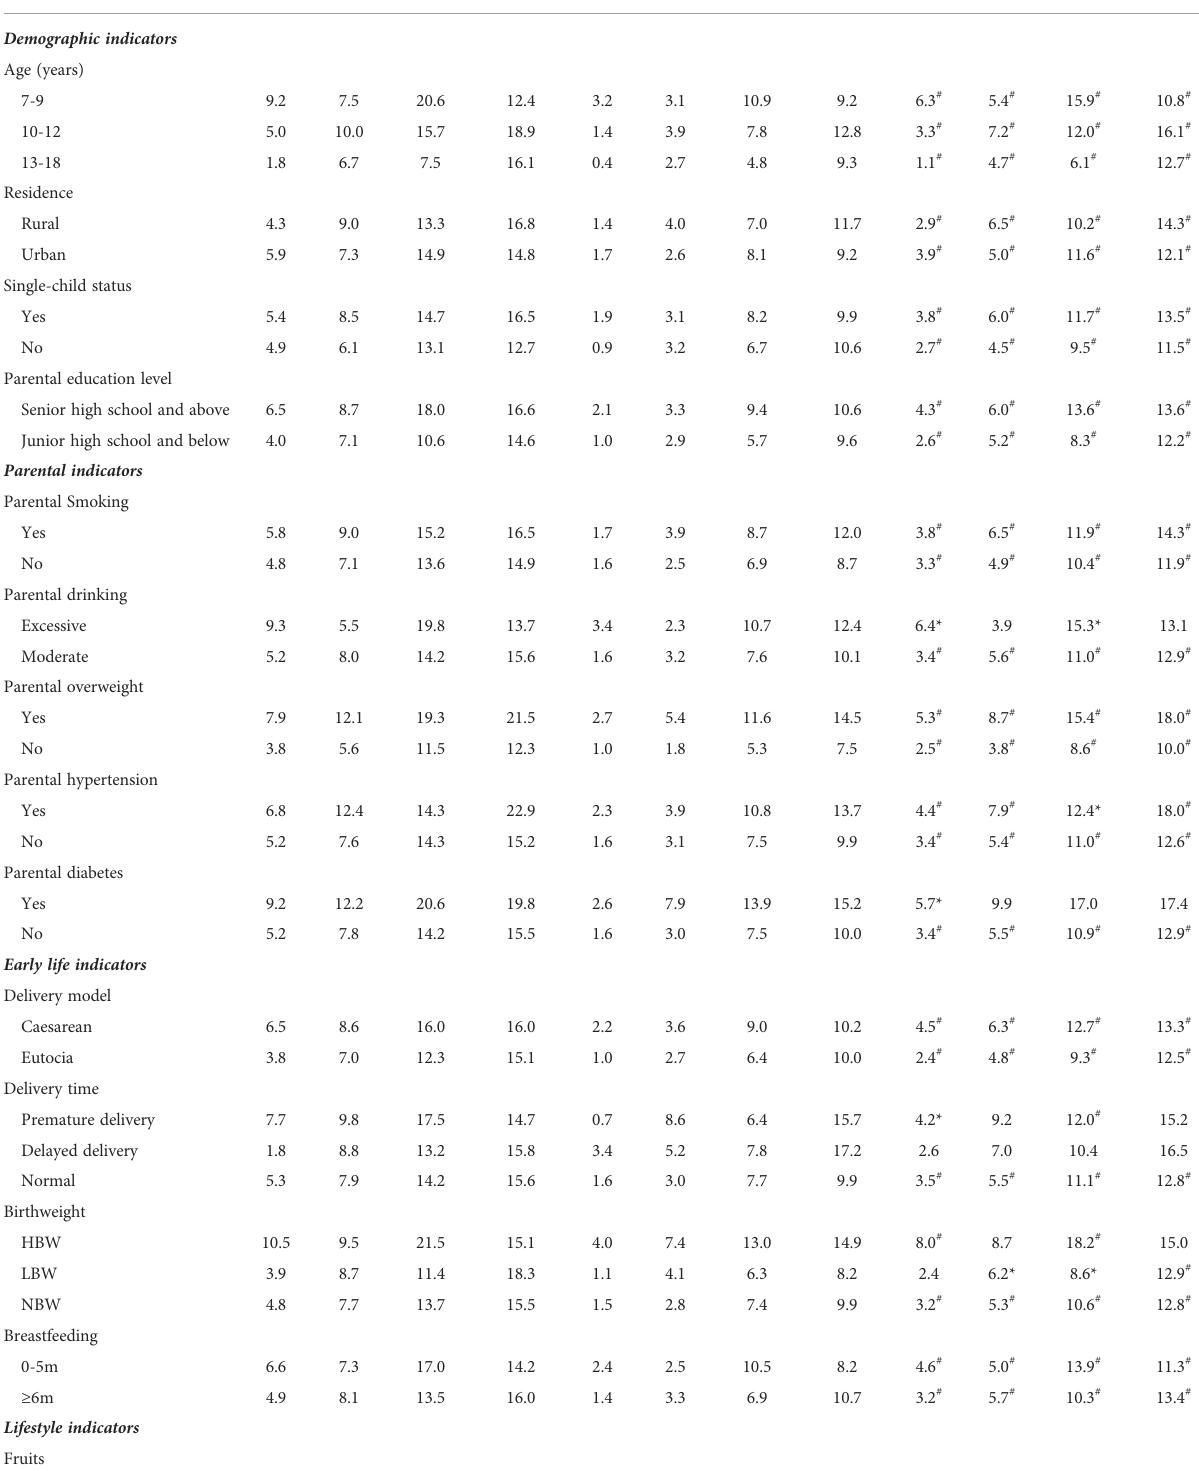
TABLE 2 The prevalence of obesity phenotypes by